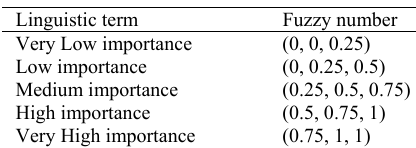
Table 2: Linguistic terms for the weight of criteria (Yazdani et al., 2011)